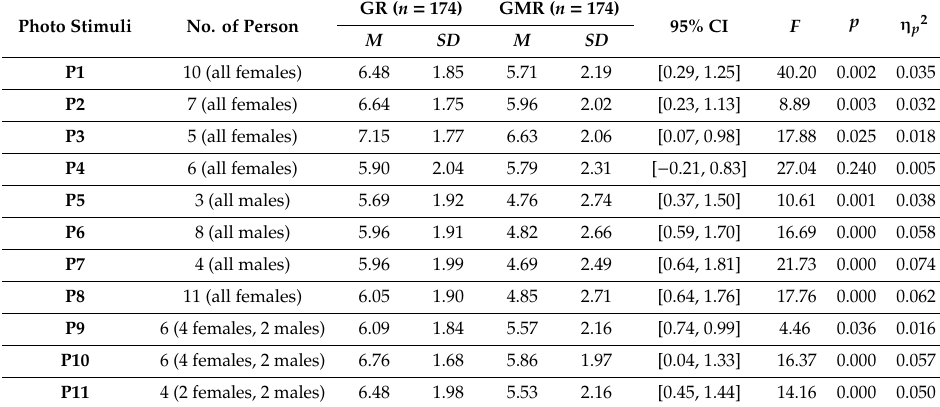
Table 3. Comparisons between the GR and GMR from Study Ic ( n = 136).